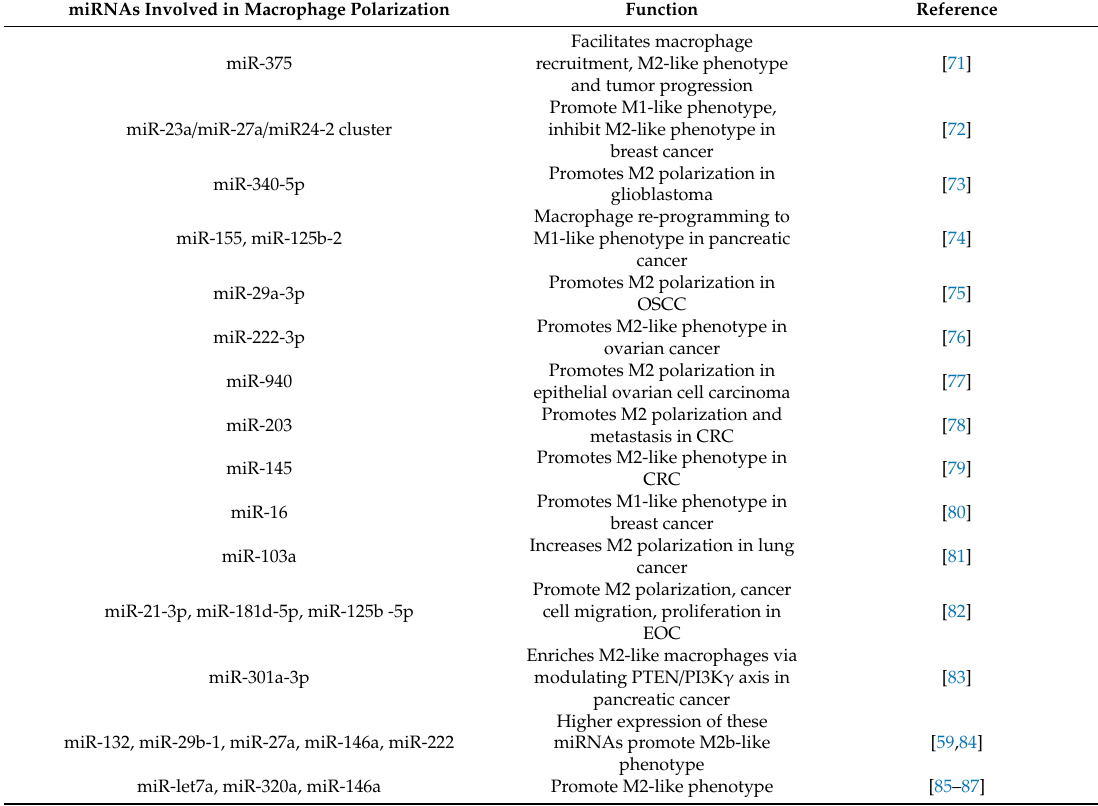
Table 1. List of miRNAs regulating macrophage